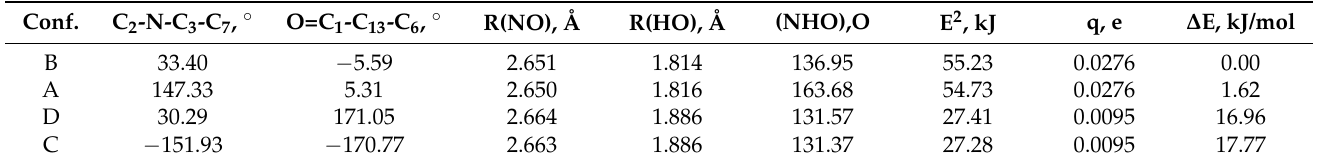
second order (E 2 ), and charge transfer (q) for intramolecular hydrogen bonds for four FFA conformers. Conf.